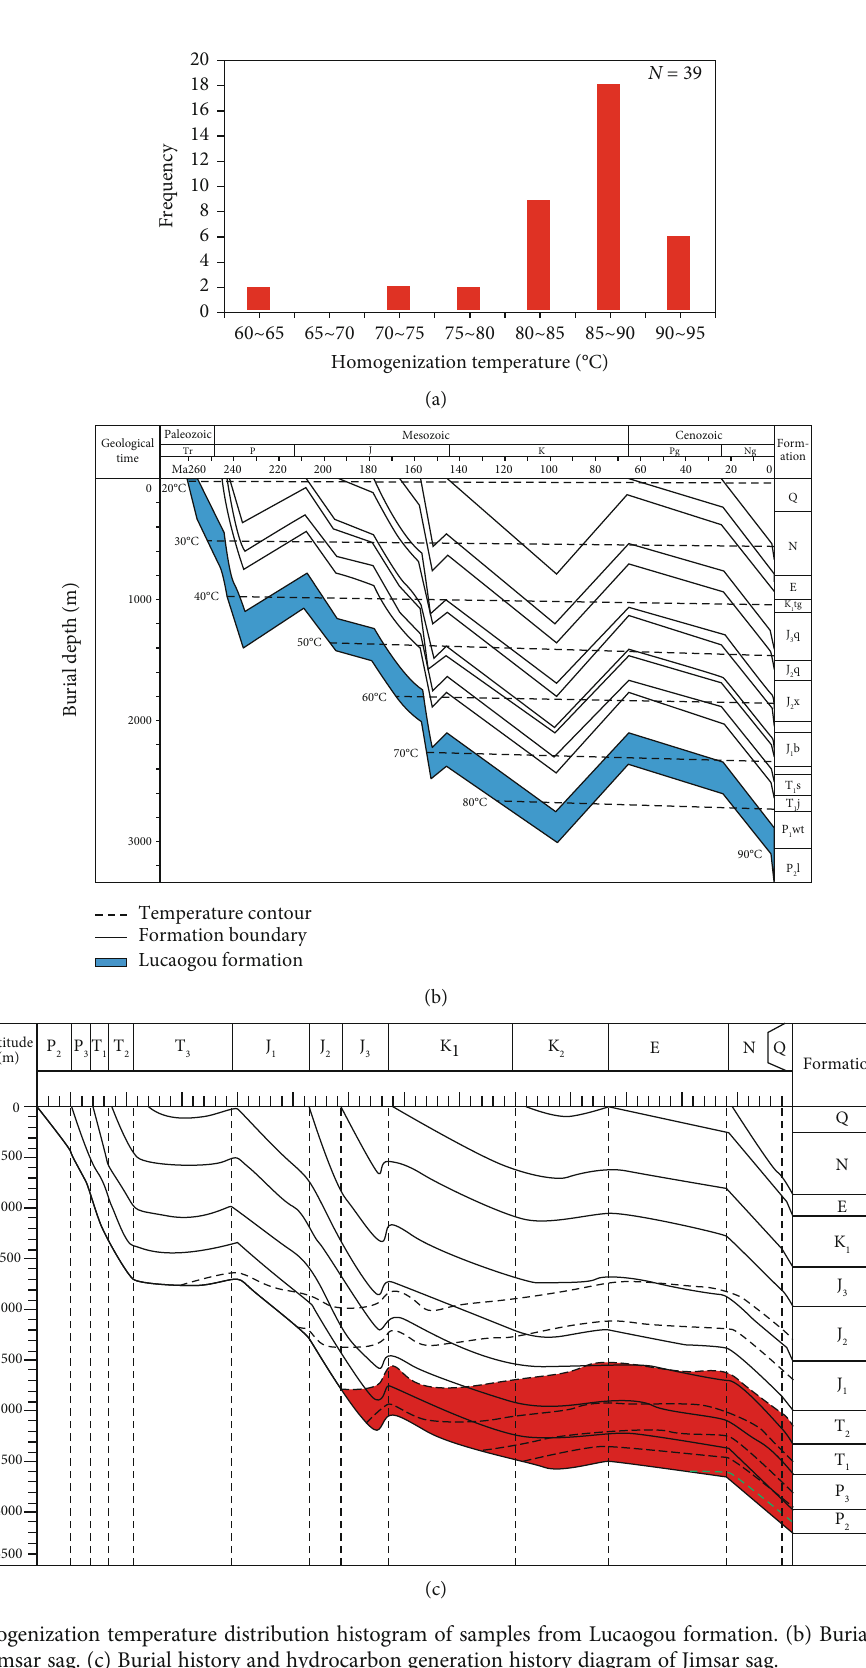
Figure 12: (a) Homogenization temperature distribution histogram of samples from Lucaogou formation. (b) Burial history and thermal history diagram of Jimsar sag. (c) Burial history and hydrocarbon generation history diagram of Jimsar